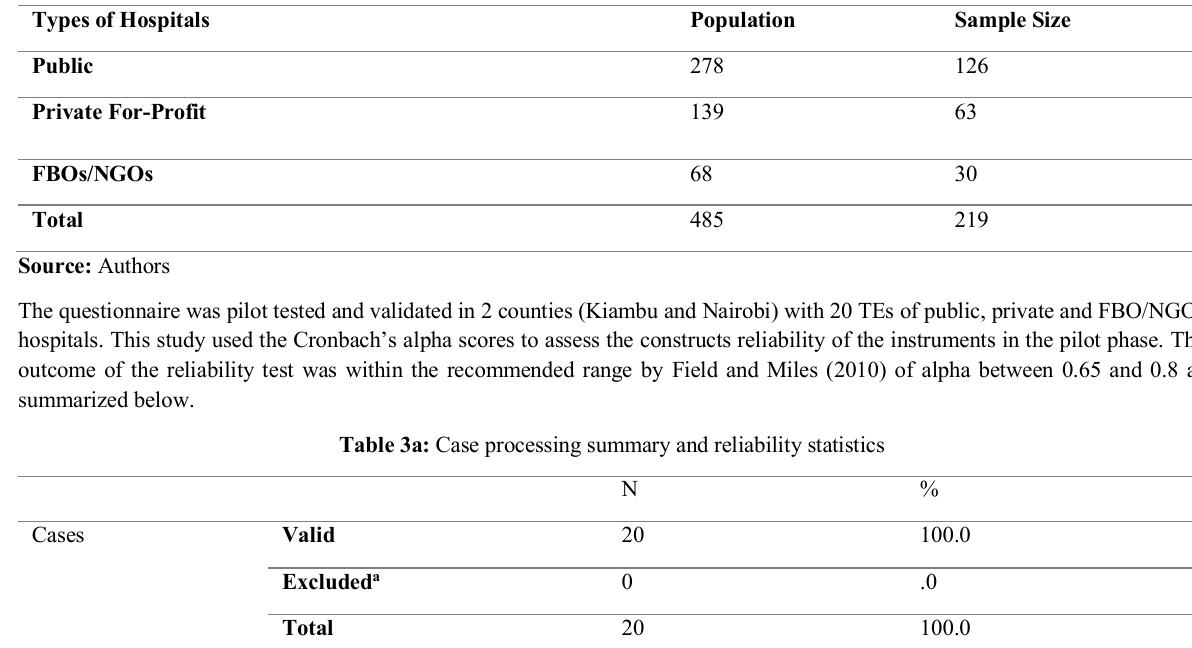
Table 3: Distribution of level 4 hospitals by types of providers/ownership (n=485)